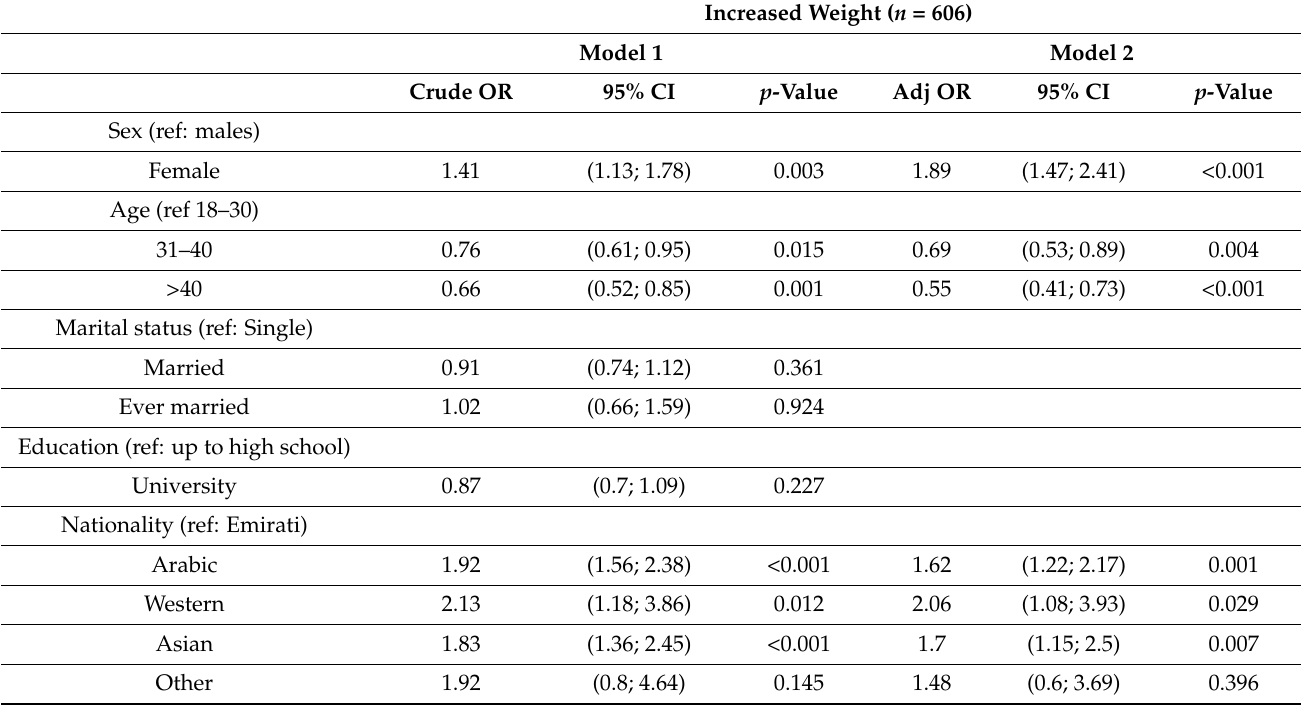
Table A2. Simple and multiple logistic regressions describing the association between increased weight and sociodemo- graphic characteristics in the study population ( n =